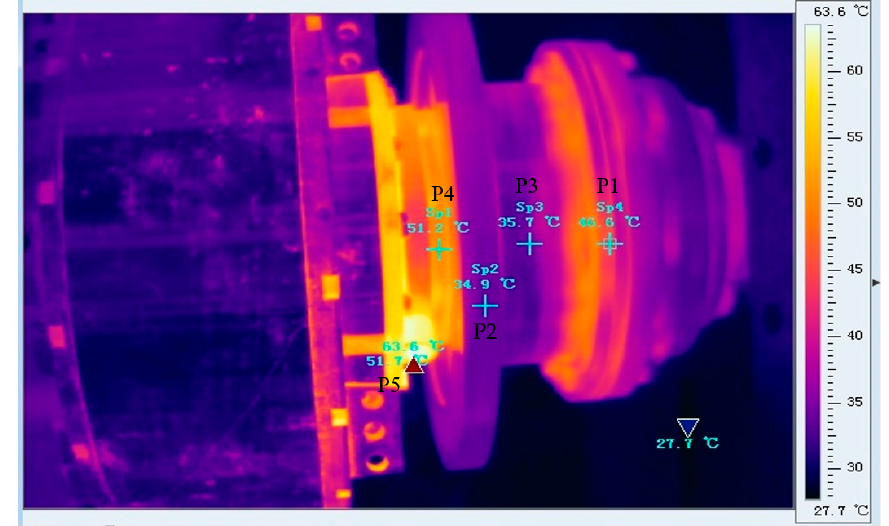
Figure 5. The temperature test result.